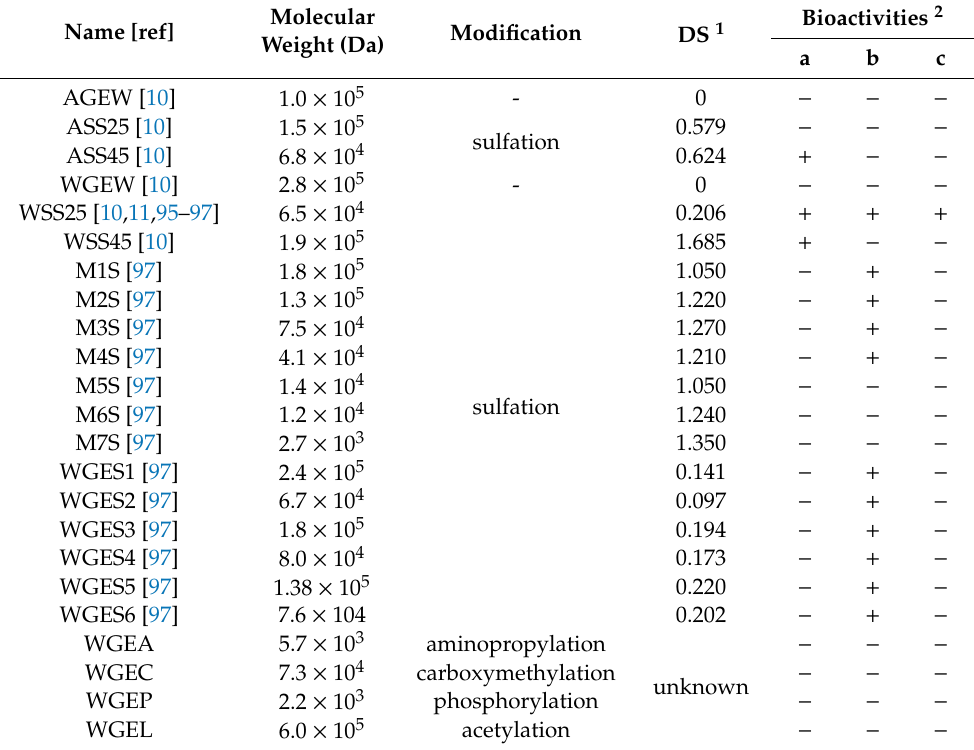
Table4. Molecularweight, derivatizationtype, degreeofsubstitution, andbioactivityofpolysaccharides from G. elata and their